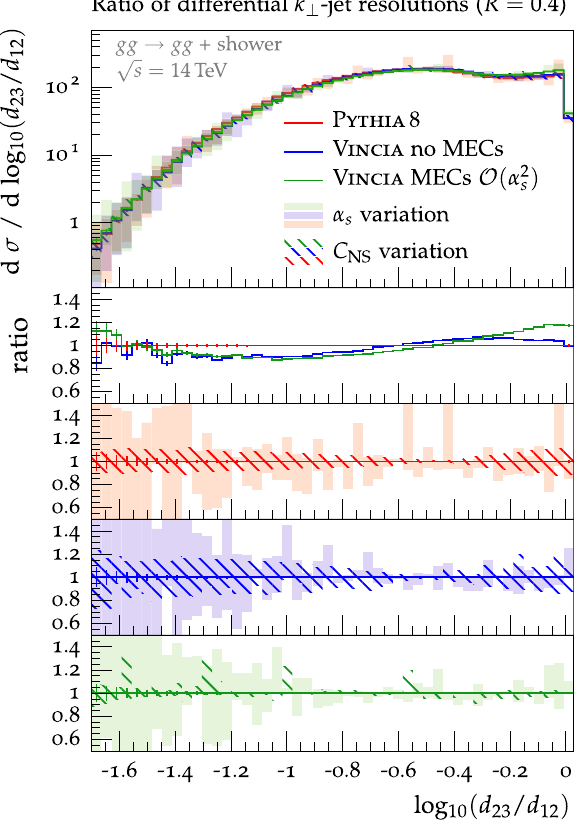
Fig. 2 Logarithmicdistributionsofratiosofdifferentialjetresolutions, d 23 / d 12 and d 56 / d 12 , for showering gg → gg events. Predictions of Pythia 8.226 and Vincia 2.200 with and without ME corrections are